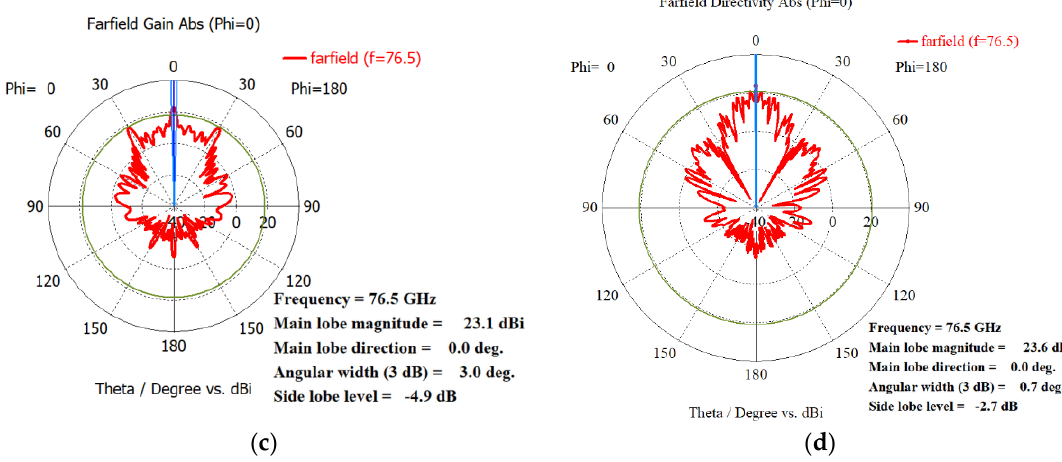
Figure 14. Polar radiation patterns of: ( a ) transmitter array of the proposed VAA, ( b ) receiver array of the proposed VAA, ( c ) transmitter array of the traditional TI’ LFMCW radar, and ( d ) receiver array of the traditional TI’ LFMCW radar.